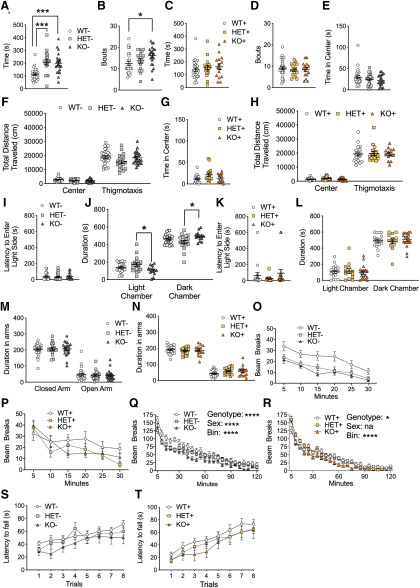
Rescue of increase repetitive grooming in Shank3+ mutant mice. A, Shank3 HET– and KO– mice displayed a significant increase in time spent grooming compared with WT– littermate mice. B, KO– mice also display a significant increase in the number of grooming bouts compared with WT mice. C, Genetically rescued Shank3 WT+, HET+, and KO+ mice all displayed similar grooming duration and (D) number of grooming bouts. In the OF test, Shank3– mice all displayed similar duration in the center (E). Additionally, Shank3– mice displayed similar distances traveled in the center and thigmotaxis regions, respectively (F). Shank3+ mice displayed similar duration in the center of the OF (G) and similar distances traveled in the center and thigmotaxis regions (H). In the light dark test, Shank3– mice displayed similar latencies to enter the light side (I). Shank3 HET– mice displayed increase duration in the light chamber compared with KO– mice (J). Additionally, HET– mice displayed a decrease in time spent in the dark chamber compared with KO– mice (J). None of the Shank3+ mice displayed a significant difference in their latency to enter the light side (K). Also, Shank3+ mice displayed similar duration in light chamber and dark chamber, respectively (L). In the elevated plus maze Shank3– mice displayed similar durations in the closed arm and open arm, respectively (M). Shank3+ mice displayed similar duration in closed arms and open arms, respectively (N). In the rearing test Shank3 HET– and KO– mice displayed reduced rearing compared with WT– mice (O). Shank3 HET+ and KO+ mice displayed similar rearing behavior when compared with WT+ mice (P). In the locomotor test KO– mice displayed a significant reduction in beam breaks over a 2-h time period when compared with HET– and WT– mice (Q). Shank3 WT+, HET+ and KO+ mice all displayed similar levels of beam breaks (R). Both Shank3– (S) and Shank3+ (T) mice displayed similar latencies to fall of the rotarod, respectively. Data represented as mean ± SEM; *p < 0.05; **p < 0.01, ***p < 0.001, ****p < 0.0001, n = 24 WT–, n = 16 HET–, n = 20 KO–, n = 24 WT+, n = 19 HET+, n = 16 KO+.